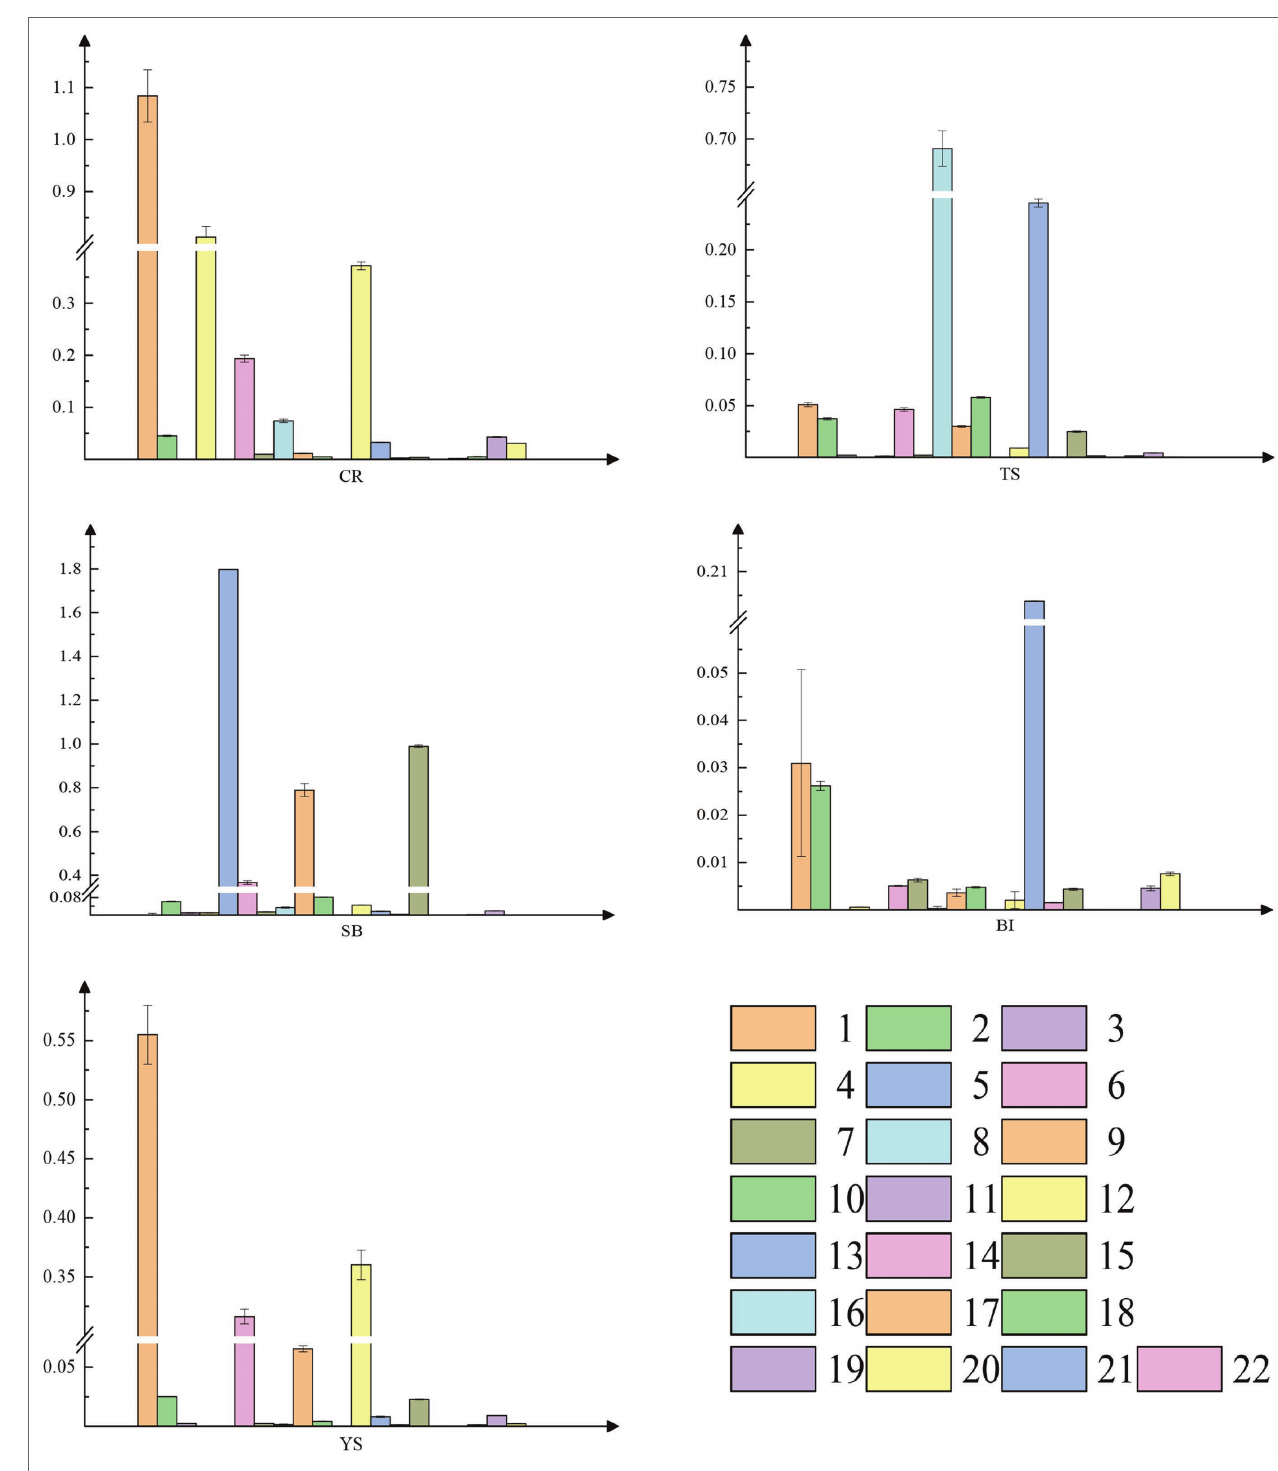
FIGURE 5 | Real-time quantitative PCR(qRT-PCR) analysis of YUCCA gene family. 1 PheYUC6-3 , 2 PheYUC9-1, 3 PheYUC2, 4 PheYUC4-2, 5 PheYUC6-1, 6 PheYUC5, 7 PheYUC4-1, 8 PheYUC3-2, 9 PheYUC1-2, 10 PheYUC8-1, 11 PheYUC6-2, 12 PheYUC9-2, 13 PheYUC3-1, 14 PheYUC4-3, 15 PheYUC1-1, 16 PheYUC8-2, 17 PheYUC7-4, 18 PheYUC7-2, 19 PheYUC7-1, 20 PheYUC7-3, 21 PheYUC11, and 22 PheYUC6-4. The reference gene is TIP41 of moso bamboo, see Supplementary Table S4 for relevant primer information. CR root tip (the tip of the bamboo root growing out of the base of the bamboo shoot), TS tip of shoot, SB sheath blade (the upper component of culm sheaths, the base is connected to the tip of sheath and is the metamorphic leaf of bamboo shoot), BI bamboo shoot internode 1/5 from the tip, and YS young